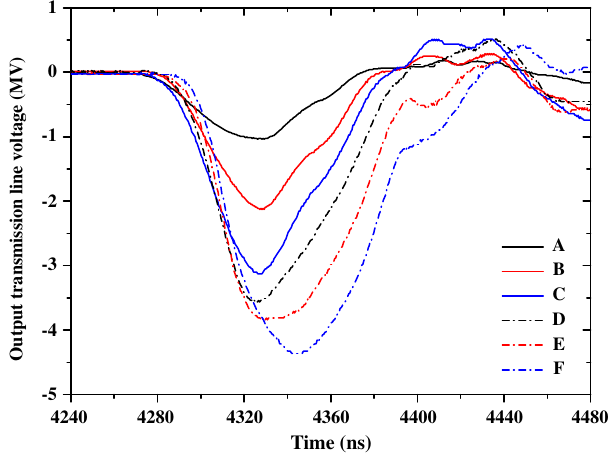
FIG. 12. Voltage waveforms acquired in the output transmis- sion line region. The positions of the D-dot monitors are depicted in Fig.